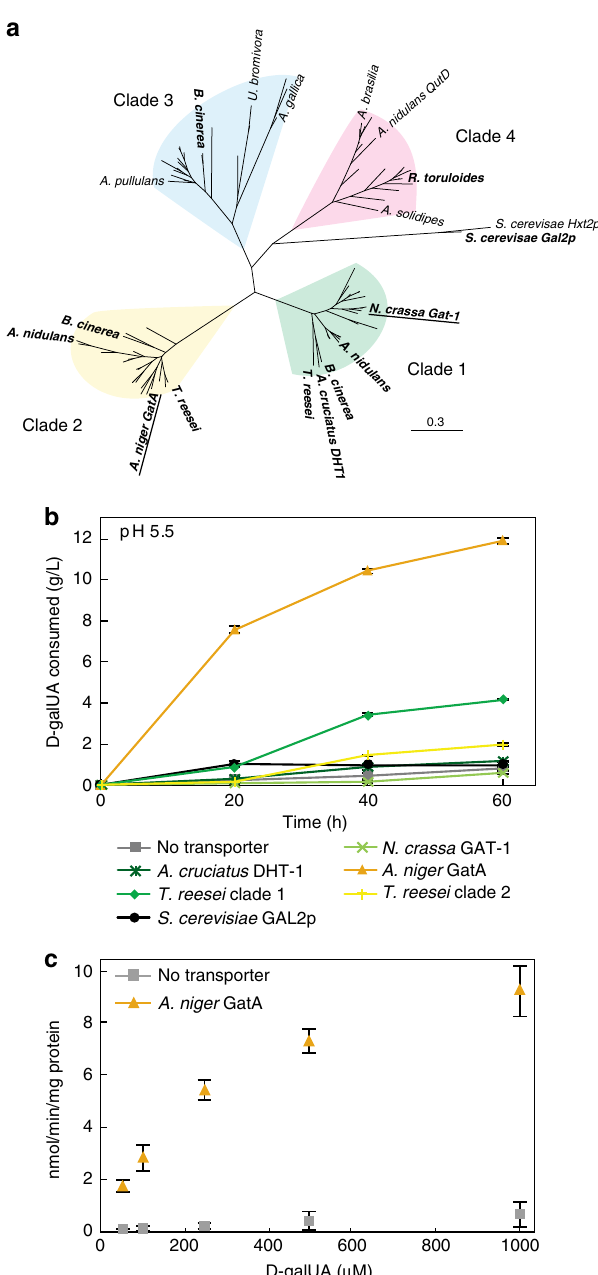
Fig. 2 Heterologous transporters enable uptake and utilization of D -galUA by S. cerevisiae at high pH. a Homologues of the eukaryotic D -galacturonic acid transporter, GAT-1, include members of the quinate transporter family (QutD). b Transporters (bolded in A) were expressed in the catabolic strain, yRJP064, and assayed for D -galUA transport and consumption at pH 5.5 (initial OD 600 = 10). c A strain expressing GatA from Aspergillus niger exhibits high- fl ux D -galUA transport in tritiated D -galUA uptake assays